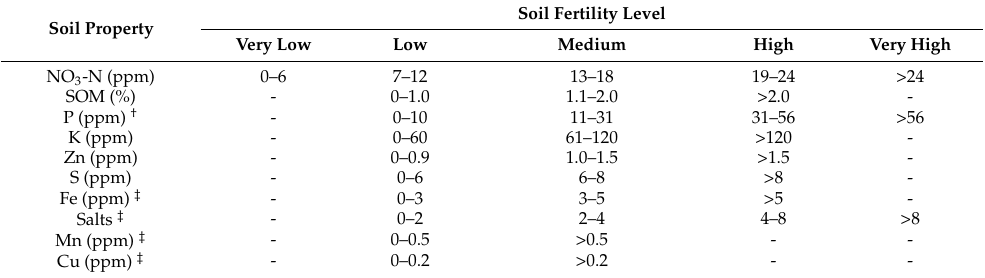
Table 4. Classification of selected soil properties values for maize fertilization in